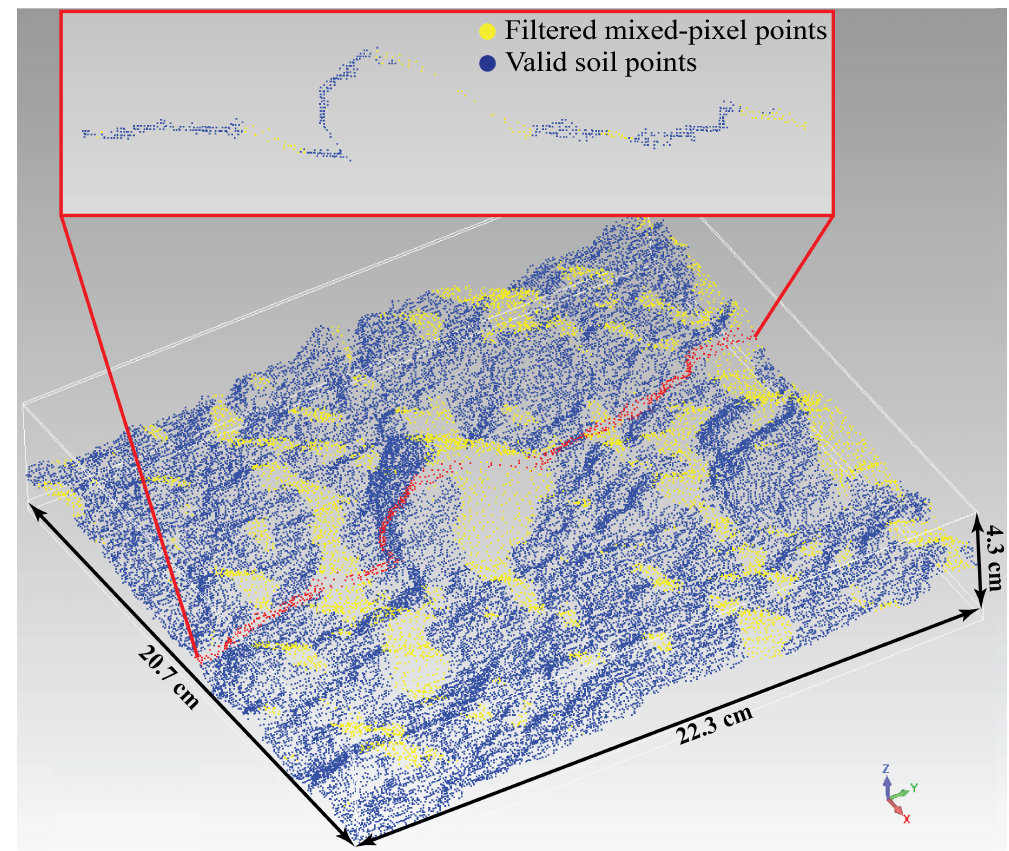
Figure 2. An example of automatically-detected mixed pixels (yellow points) in a single scan station. The top diagram shows a cross-section of mixed pixels taken approximately along the TLS’s line of